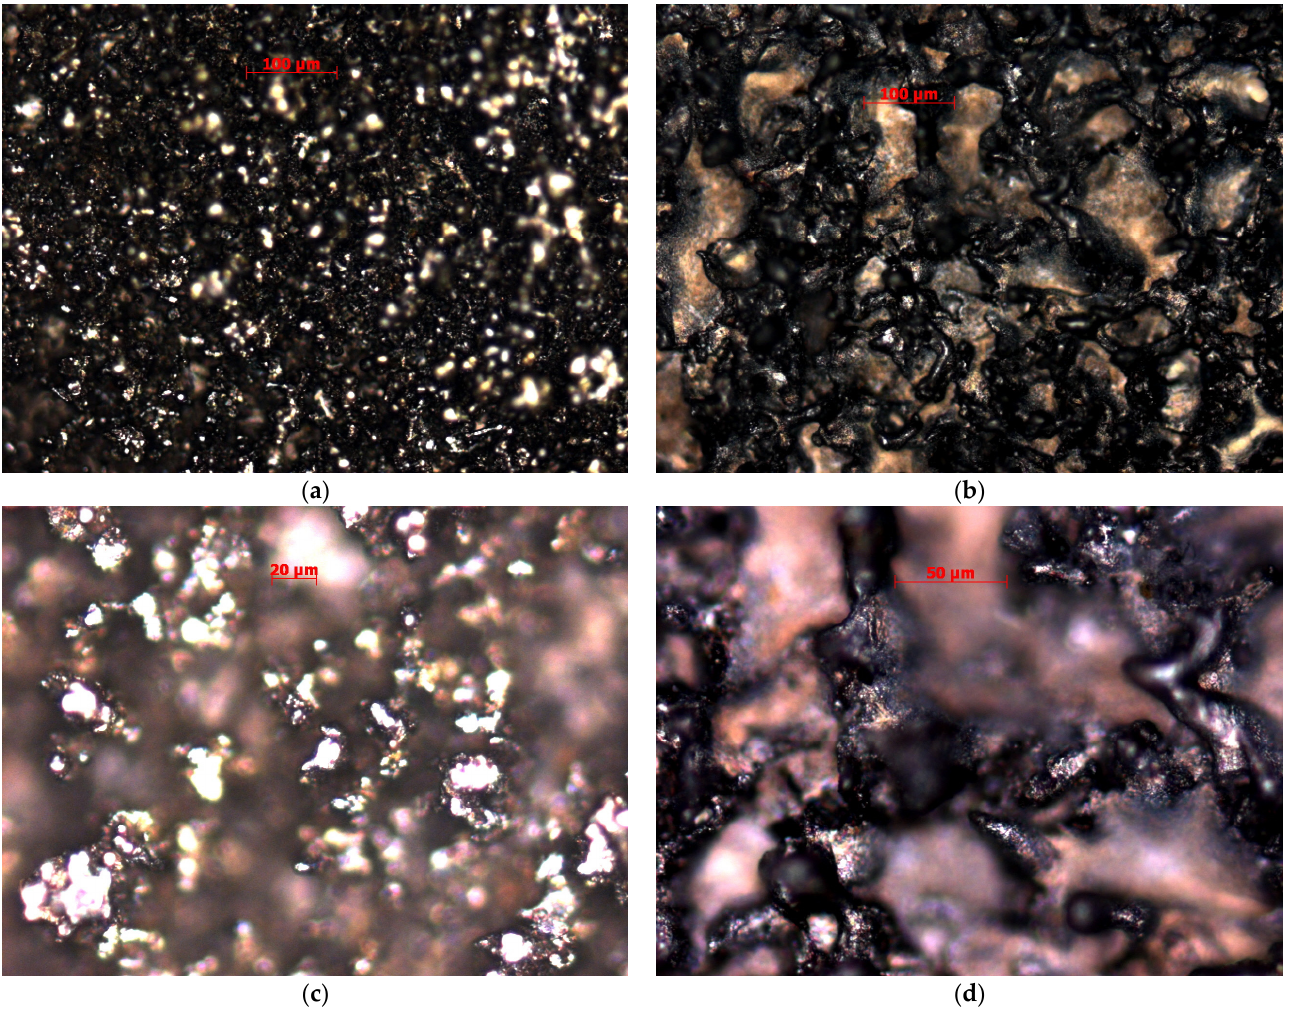
Figure 3. Topology the samples after electrical discharge machining with a brass wire tool electrode in water: ( a ) X10CrNiTi18-10 (12kH18N10T) steel, 20×; ( b ) 2024 (D16) duralumin, 20×; ( c ) X10CrNiTi18-10 (12kH18N10T) steel, 50×; ( d ) 2024 (D16) duralumin, 50×.